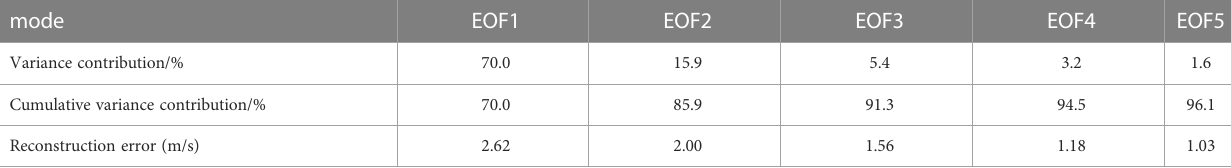
TABLE 1 Properties of reconstruction of different orders of the empirical orthogonal function. mode